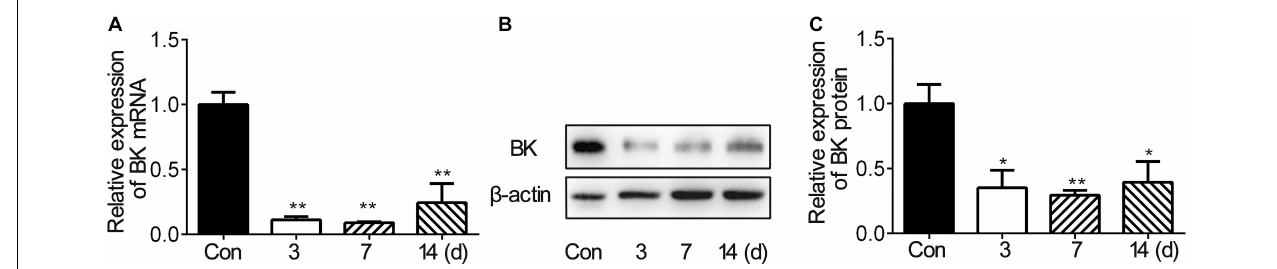
FIGURE 1 | BK expression in the ipsilateral hemisphere decreased after mouse tMCAO. (A) Bar graph shows the BK mRNA expression in the mouse ipsilateral hemisphere at 3, 7, and 14 days after 90-min tMCAO. Data are mean ± SE, n = 3–7 per group. ** p < 0.05. tMCAO vs. control. (B) Representative image of Western blot shows BK expression in the mouse ipsilateral hemisphere at 3, 7, and 14 days after 90-min tMCAO. (C) Bar graph shows that the semiquantitative data of BK protein levels at 3, 7, and 14 days after tMCAO. Data are mean ± SE, n = 3 per group. * p < 0.05, ** p < 0.01, tMCAO vs. control.